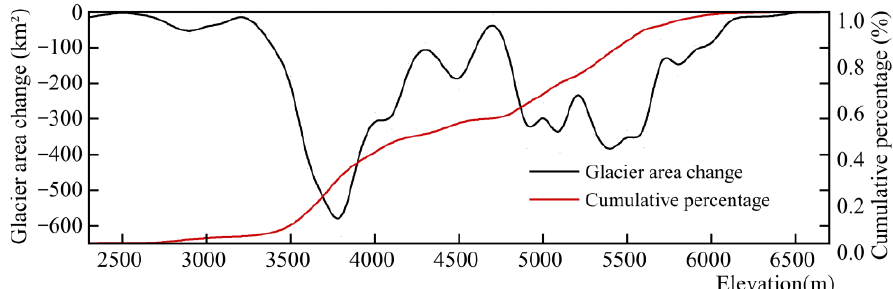
Figure 4. Changes in glacier area in different elevations of Xinjiang.